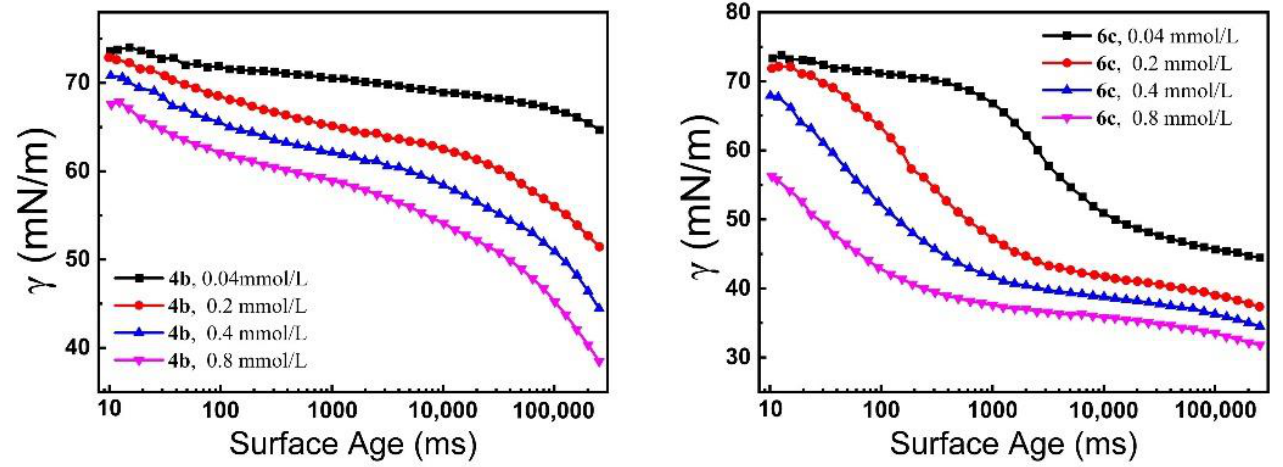
Figure 5. Surface-age-dependence of dynamic surface tension data for 4a , 6a , and 6b at various concentrations.